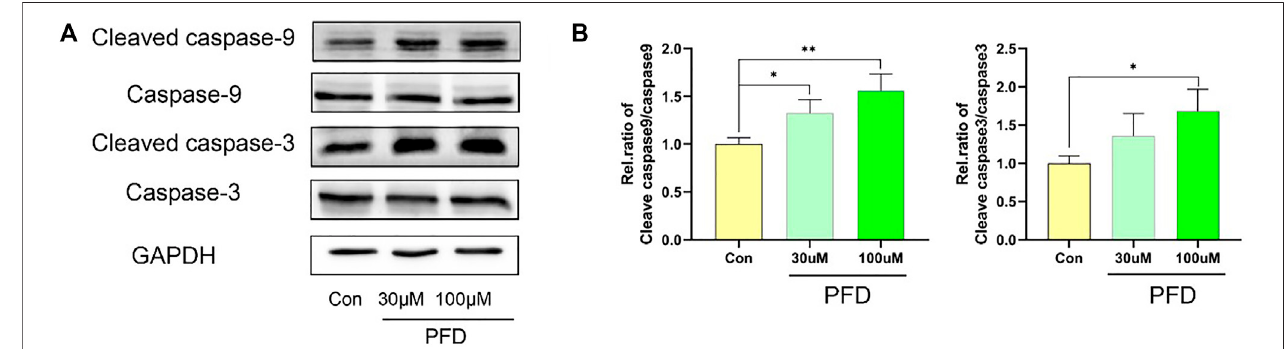
FIGURE 3 | High concentrations of PFD inhibit EA.hy926 cell tube formation by promoting apoptosis. The EA.hy926 cells were stimulated with PFD (100 nM) for 24 h, followed by assessment of cleaved caspase 9, caspase 9, cleaved caspase 3, and caspase 3 expression in cell lysates by western blot analysis. (A) Cleaved caspase 9, caspase 9, cleaved caspase 3, and caspase 3 protein expression. (B) Summary of the statistical analysis, * p < 0.05; ** p <